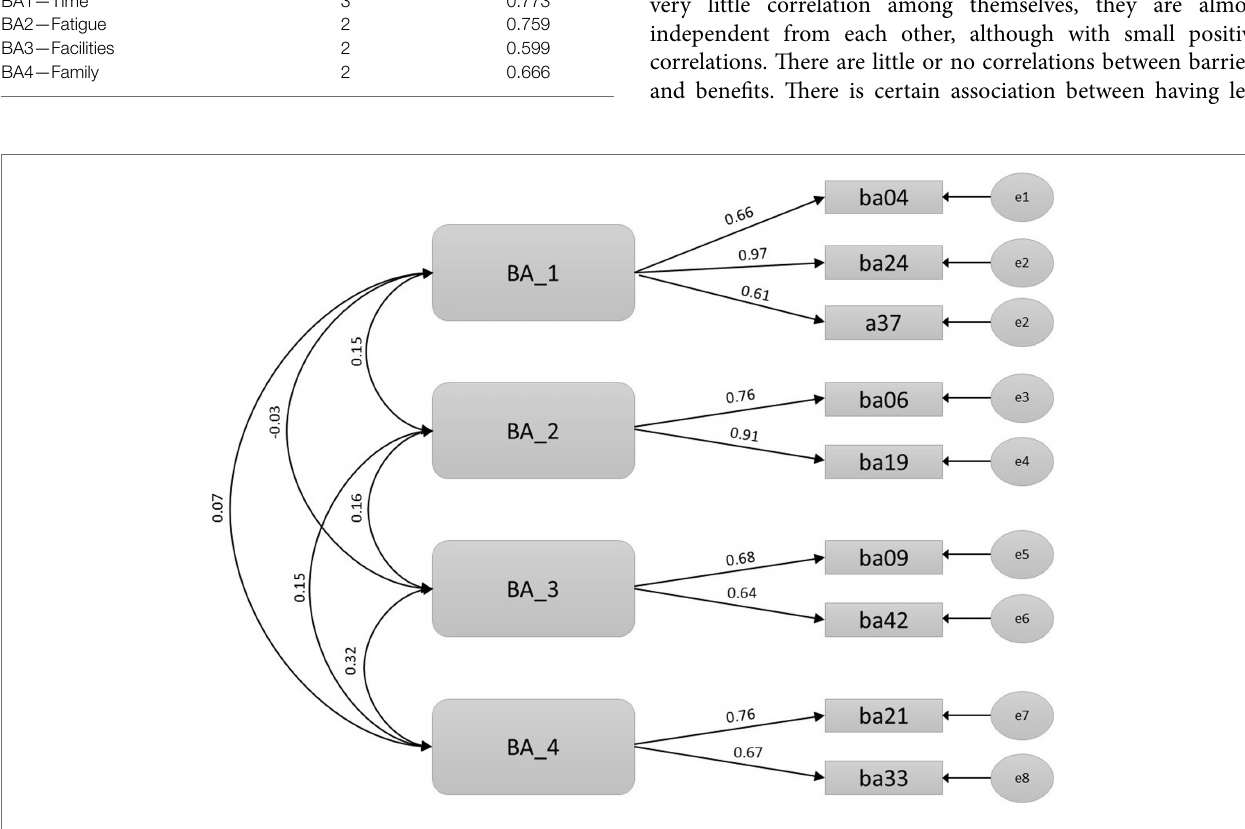
FIGURE 1 | Benefit factors’ measurement model.